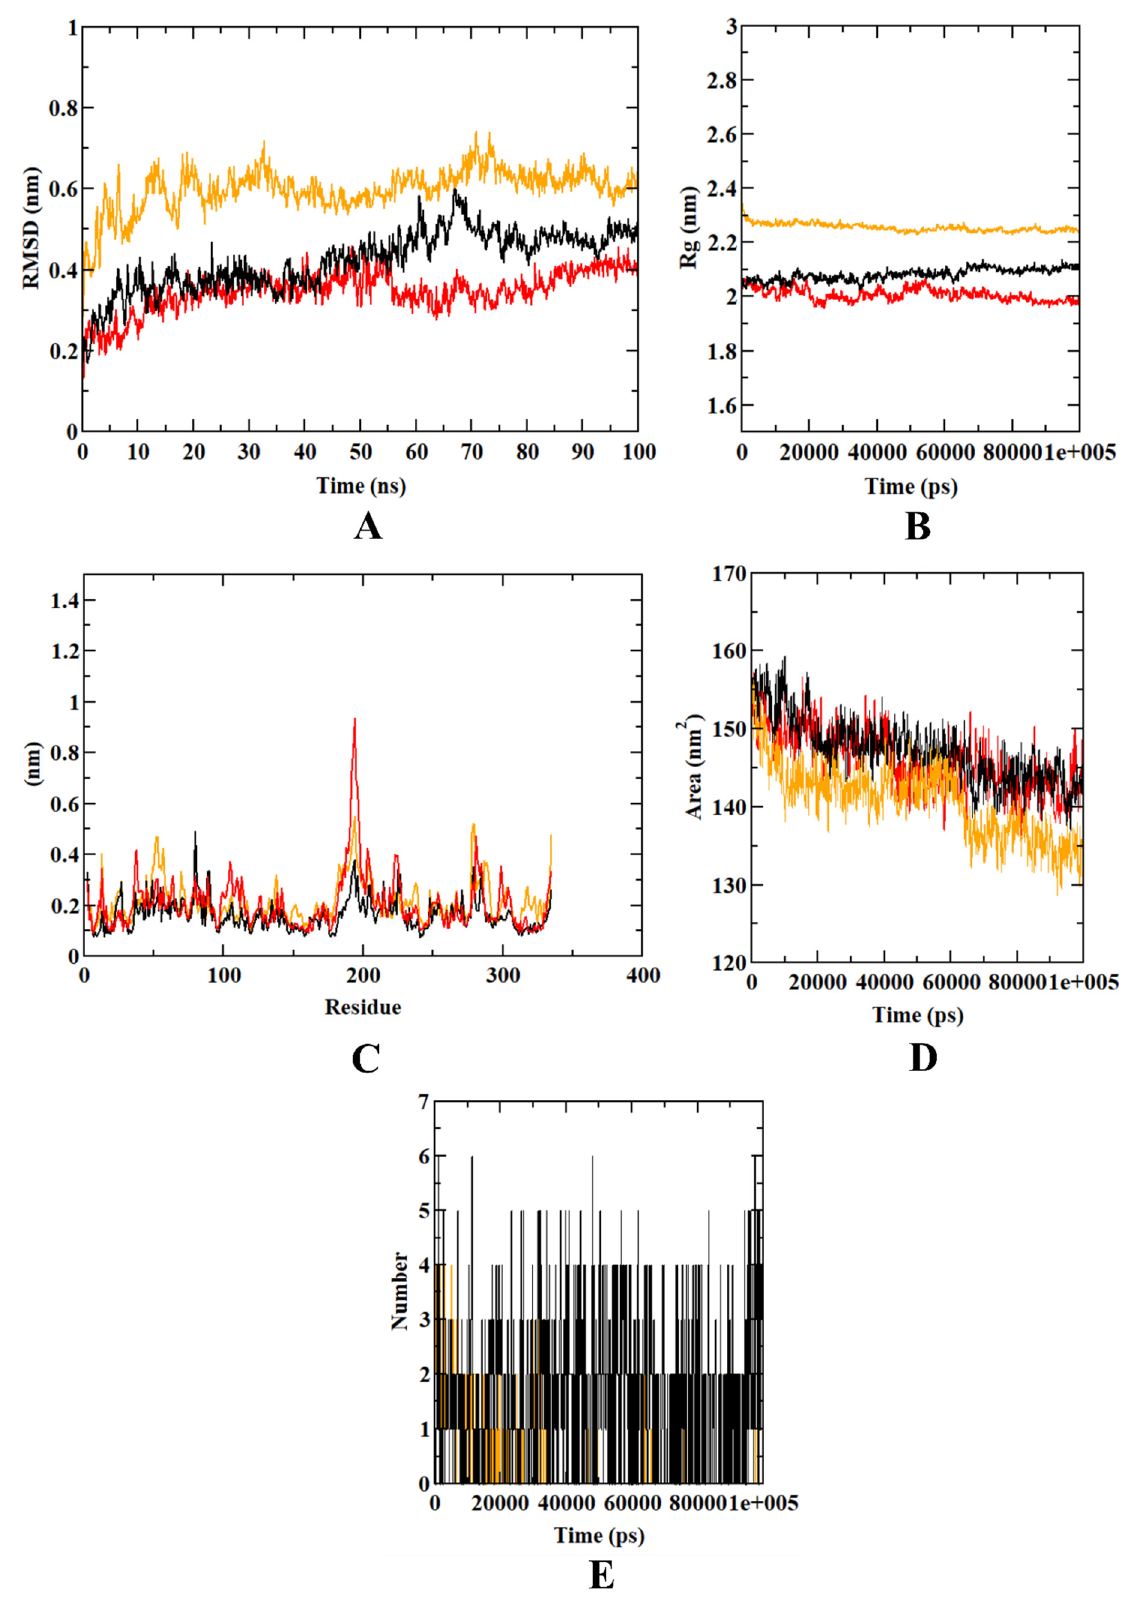
Figure 8. Analysis of RMSD, RMSF, Rg, SASA, and number of hydrogen bonds of GAPDH–isoeugenol complex (black), GAPDH–myrcene complex (orange), and GAPDH protein backbone atoms (red) at 100 ns. ( A ) RMSD of protein complex and protein backbone. ( B ) RMSF. ( C ) Radius of gyration (Rg). ( D ) SASA. ( E ) Ligand hydrogen bonds. Source like 1e+005 means 1 × 10 5 .